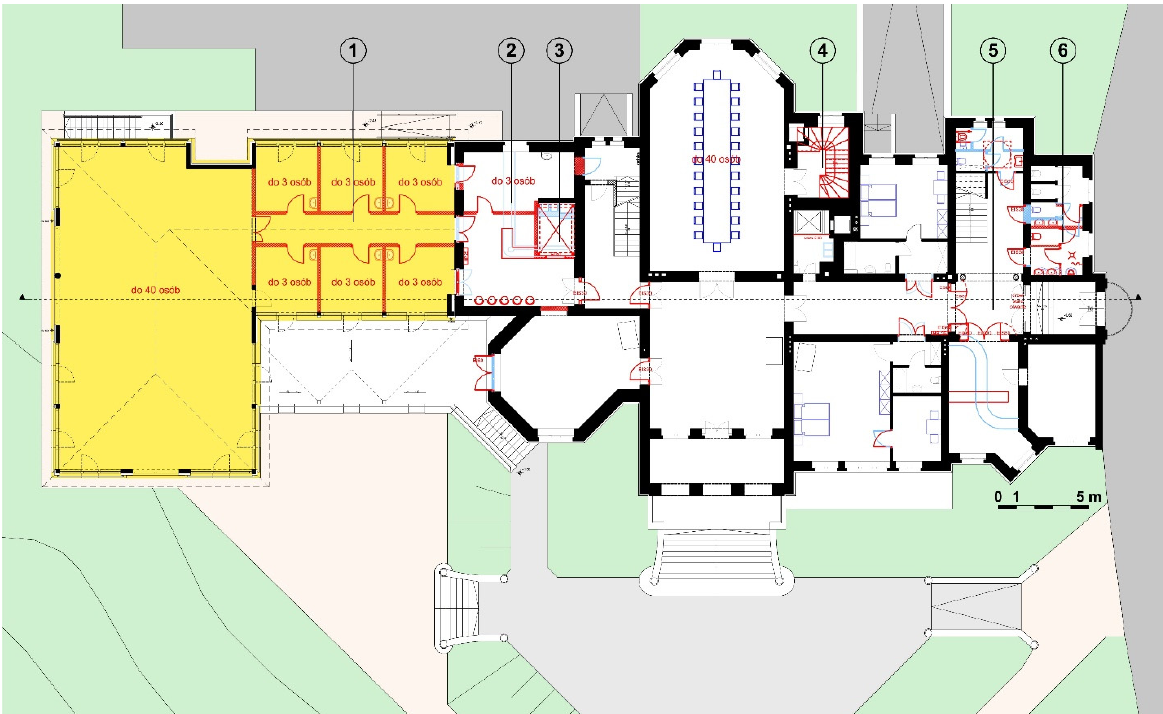
Figure 10. The adaptive re-use of the ground floor interiors of the Palace in Maciejewo for a nursing home function. Plan of the ground floor with extension built in 2000. The plan of arrangement with marked essential introduced changes: 1—division of the ball room into 6 cabinets for the health care unit; 2—the health-care reception; 3—the new passenger-goods lift with rescue function; 4—connection of the kitchen in the basement with central dining room; 5—protection arrangements at escape routes; 6—toilets for handicaped. Project developed by: Urbicon Sp ó łka z o.o. Szczecin;